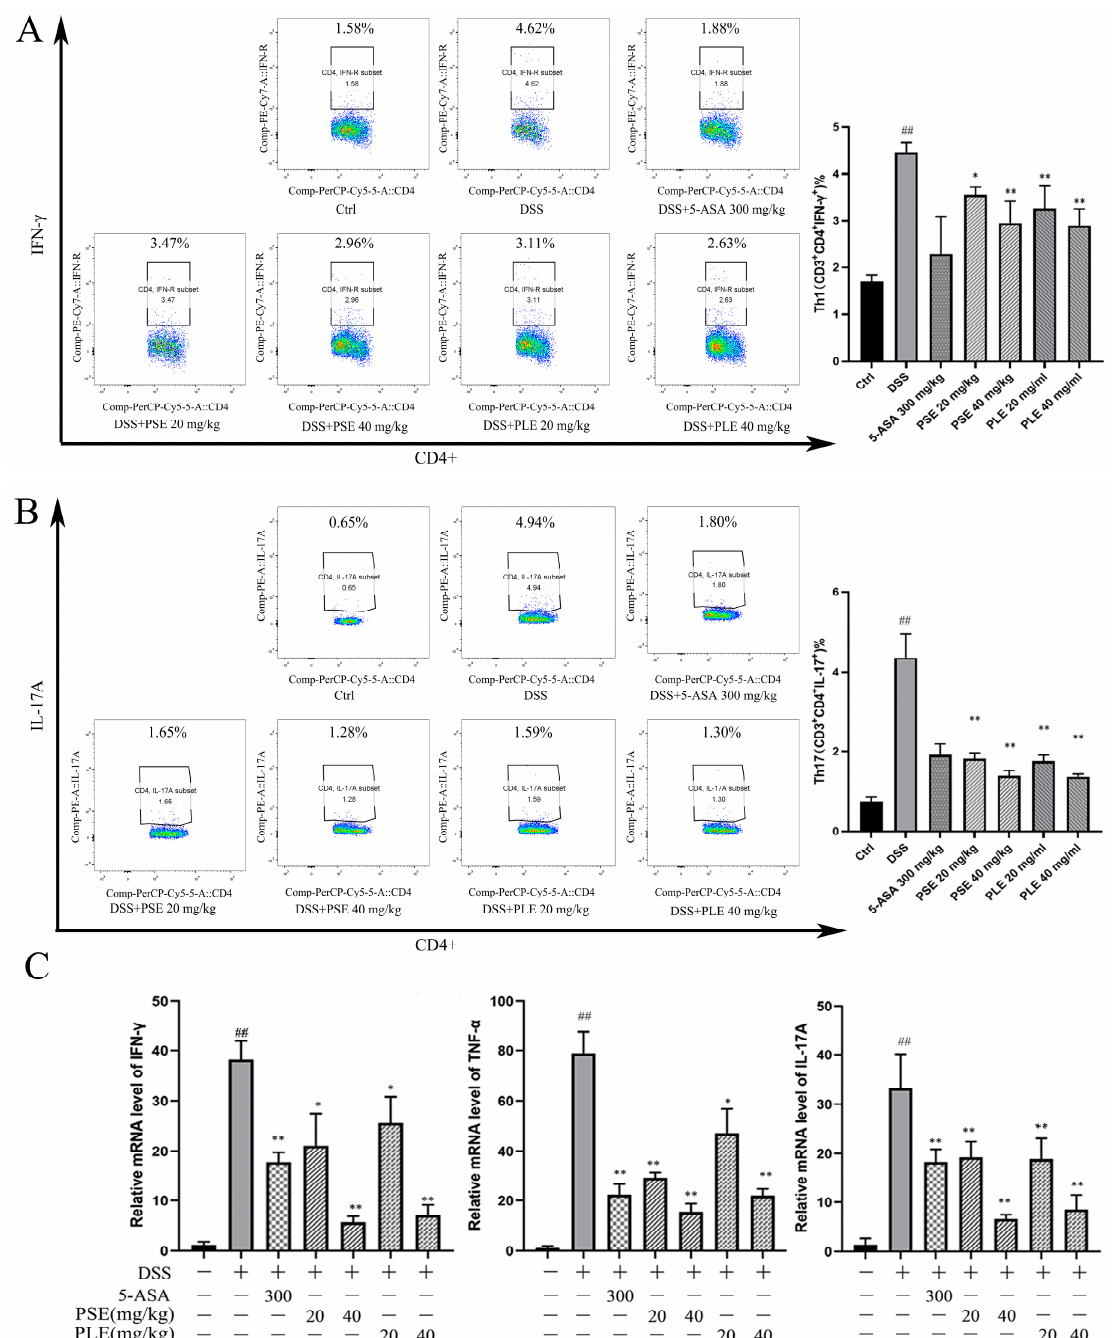
Figure 5. The effect of PSE and PLE on the expression of inflammatory factors in the spleen of mice with colitis. Splenic lymphocytes were obtained on day 10 and stimulated by PMA and BFA for 4 h. The intracellular IFN- γ ( A ) and IL-17A ( B ) production in CD4 + T cells were measured by flow cytometry. ( C ) The mRNA levels of ifn- γ , tnf- α and il-17A in the spleen were assessed by quantitative RT-PCR. Data are represented as mean ± SD of three independent experiments. The “+” indicates that the substance (3.5% DSS) was added, and the “–” indicates that the substance was not added. ## p < 0.01 vs vehicle group, * p < 0.05, ** p < 0.01 vs. model